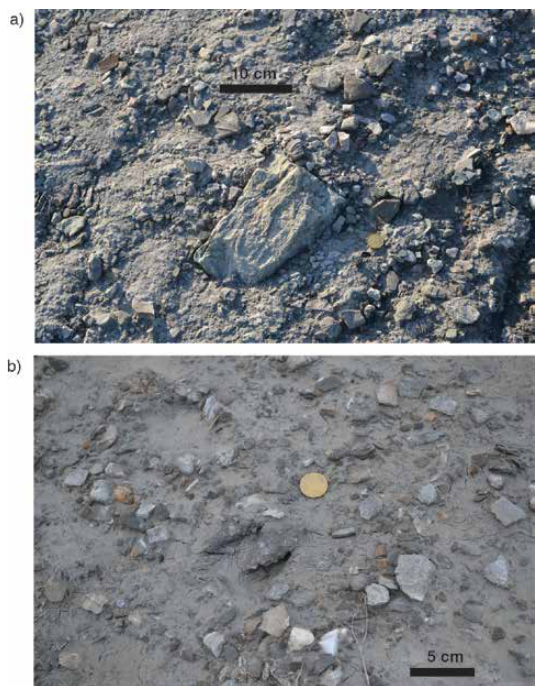
650 Fig. 3. Erupted clasts in paleodeposits from (a) Regnano and Figure 3: Erupted clasts in paleodeposits from a) Regnano and b) Puianello. The 651 largest clasts in these images are 22.9 cm and 4.5 cm, respectively. 652 (b) Puianello. The largest clasts in these images are 22.9cm and 653 4.5cm,